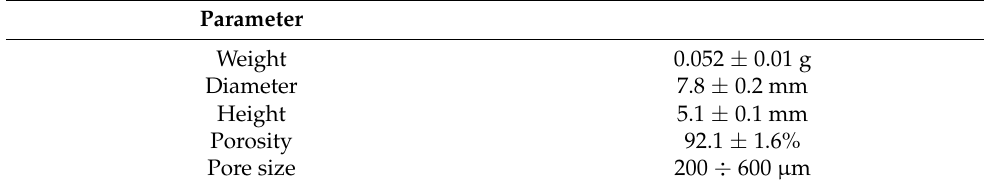
Table 3. Average dimensions of pure BG scaffolds.